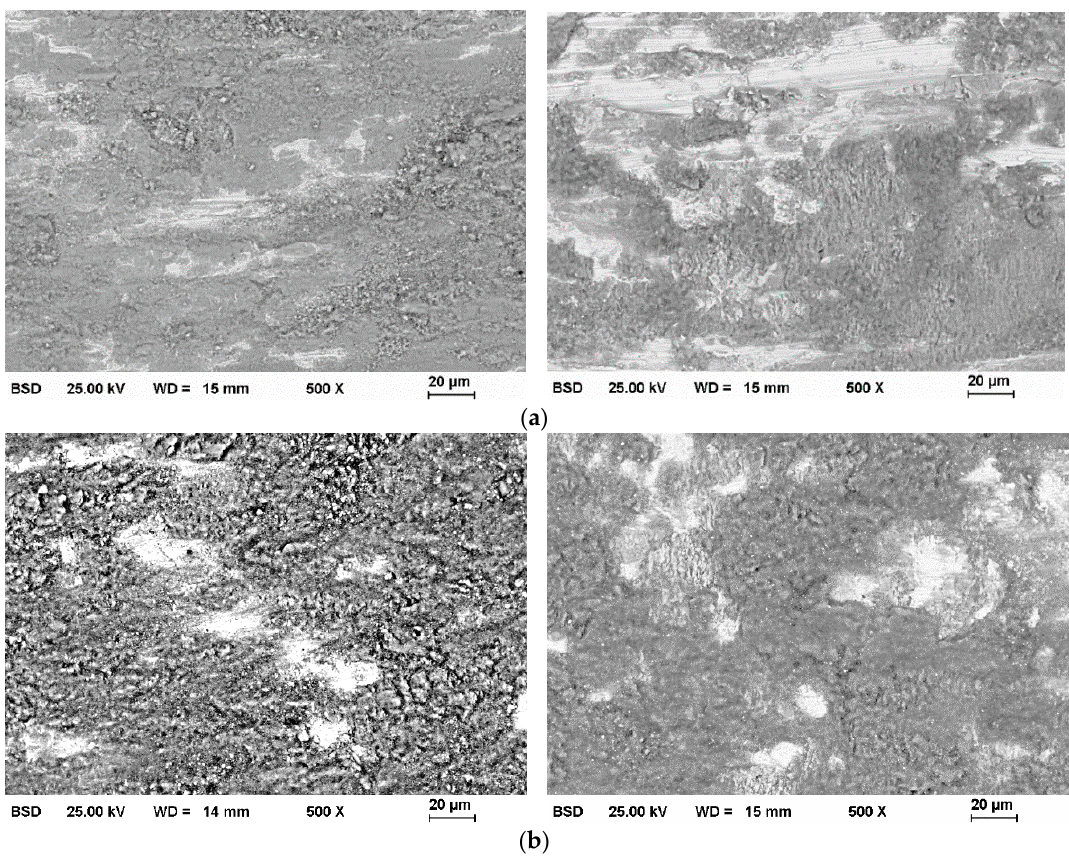
Figure 7. SEM images (BSD) of CrFeCoNi surface in untreated (left) and borided (right) state after reciprocating wear test: ( a ) casting and ( b ) HVOF coating.